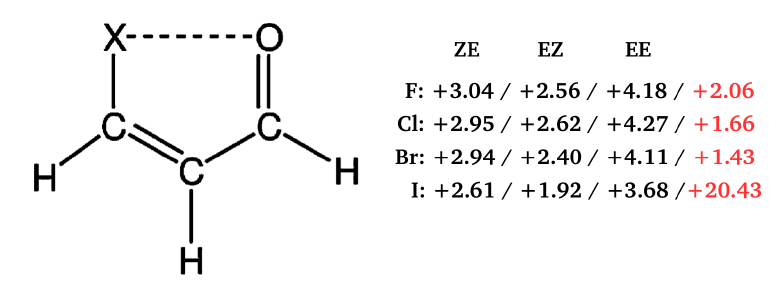
Figure 13. Interaction energies (in kcal/mol) of the X · · · O (X = F, Cl, Br, I) contact obtained [43] by either OCM ( black ) or GCM ( red ). The MP2/aug-cc-pVTZ level of theory was used for all systems but that with Y = I, for which MP2/aug-cc-pVTZ-PP was used